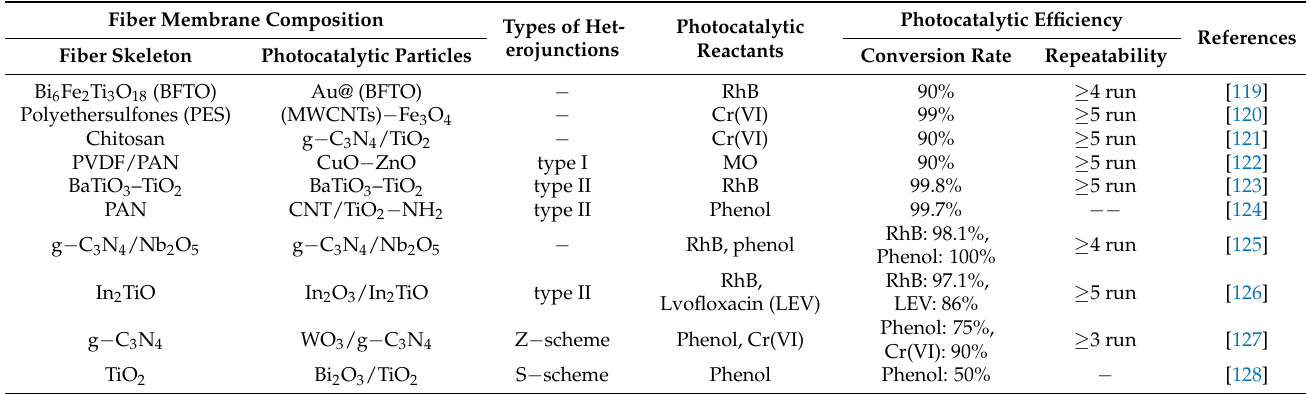
Table 1. Application of nanofibers loaded with photocatalytic particles for photocatalytic degradation of pollutants in